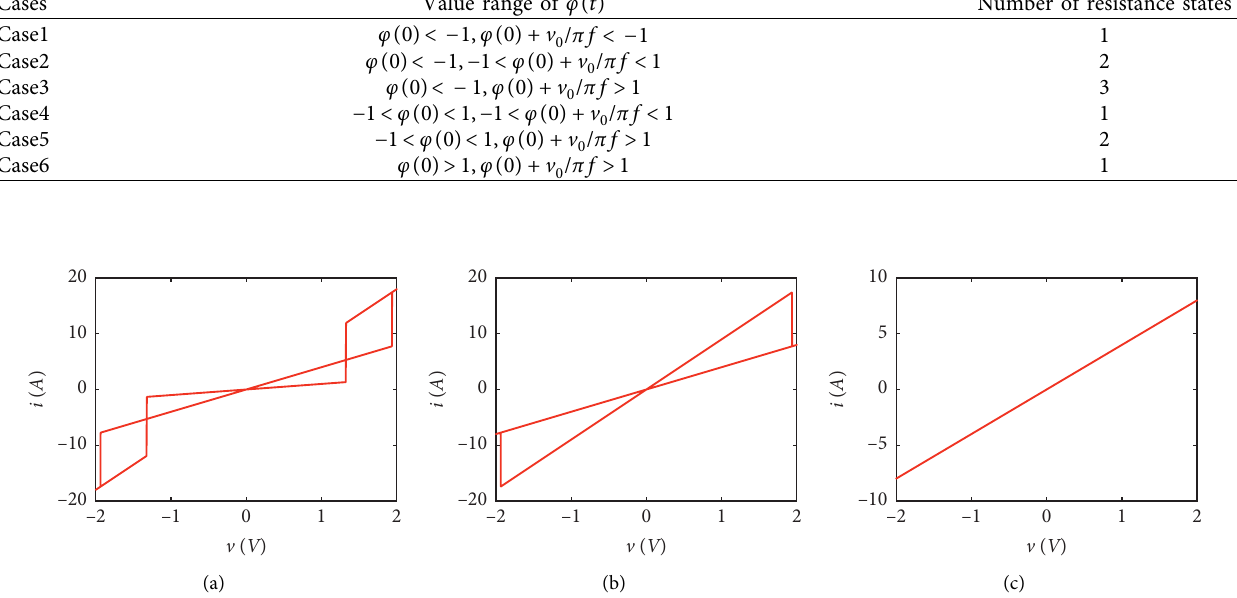
Figure 1: Characteristic curves of voltage-controlled tri-valued memristor model: (a) φ − q curve; (b) φ − G curve. Table 1: Relationship between the number of resistance states of tri valued memristors and φ ( t ) . Cases